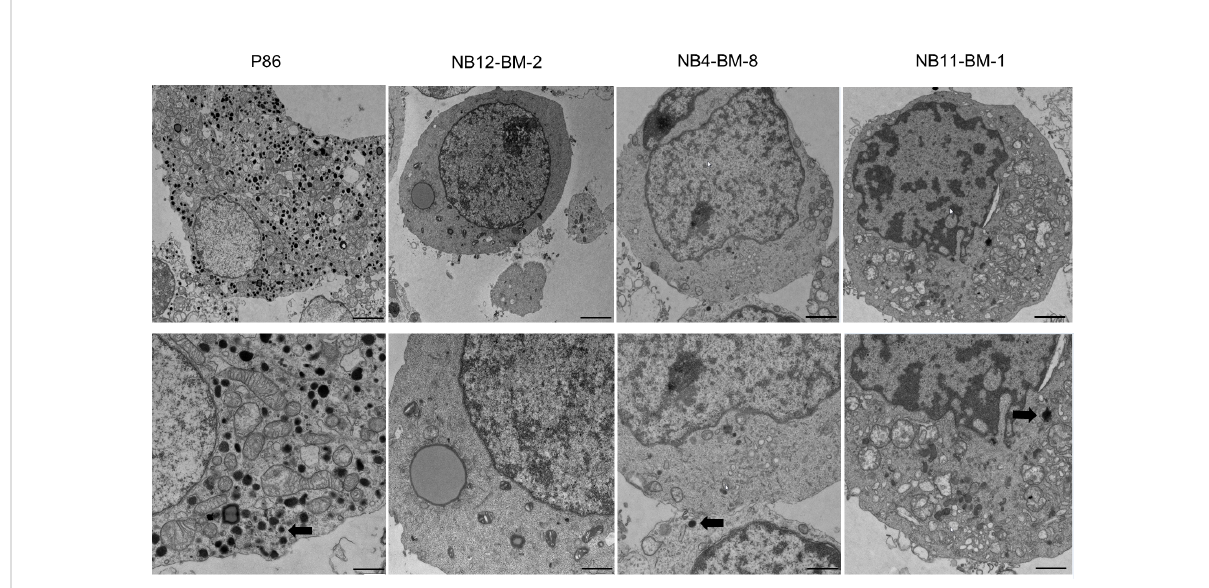
FIGURE 3 Analysis of the amount of neurosecretory vesicles in primary NB and PHEO cells by electron microscopy. Representative images of electron micrographs of PHEO/PGL and NB-PDX cells dissociated from primary tumor biopsies and xenografts, respectively. Lower panels: zoom of upper panels showing in details the cytoplasm. Thick arrows shows the electron dense content that correspond to CATs in neurosecretory vesicles. Scale bars: 1µm (upper panels, 1 st and 2 nd column), 2µm (upper panels, 3 rd and 4 th column) and 500nm (lower